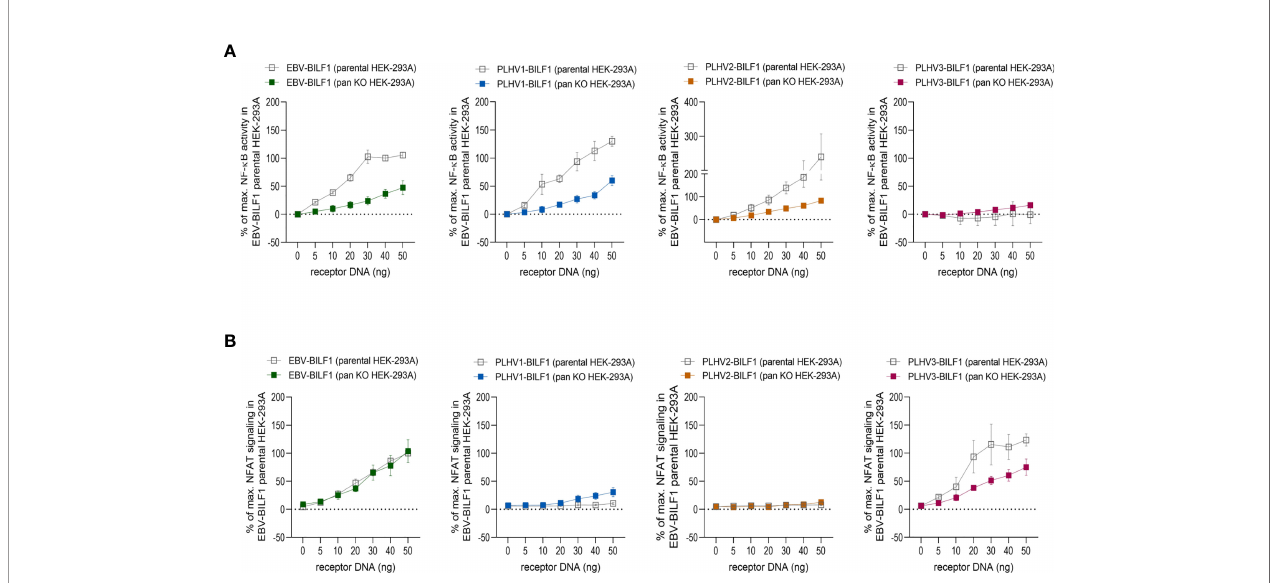
FIGURE 3 | BILF1 receptor signaling in CRISPR/Cas9 modi fi ed HEK-293A cells. (A) NF- k B and (B) NFAT activity was determined in parental HEK-293A cells and HEK-293A cells depleted of various G proteins ( D G a s/olf/q/11/12/13/z ) by CRISPR/Cas9 technology (pan KO HEK-293A cells). We used 30ng/well of (A) NF- k B and (B) NFAT cis-reporter plasmid. Graphs represent the receptor dependent NF- k B and NFAT activity relative to the maximal activity of EBV-BILF1 in parental cells (values are means ± SEM, n =